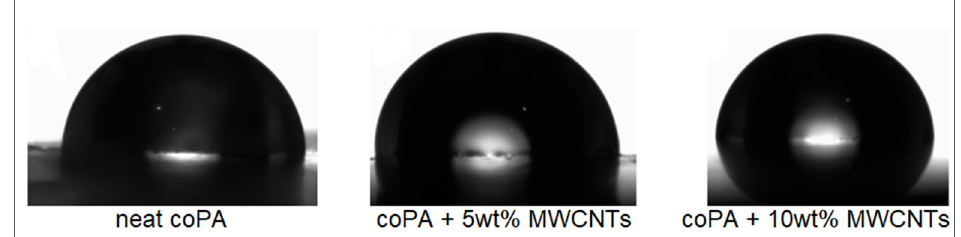
Figure 9. Images taken during contact angle measurement showing the effect of MWCNTs addition on the wettabily of coPA hot melt.